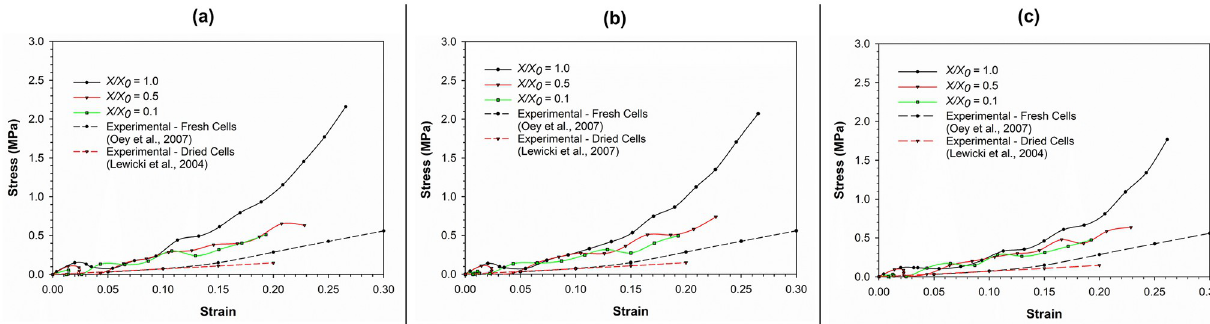
Fig 9. The stress-strain relationships demonstrated by the SPH-CG cell computational model at different dryness levels. at: (a) high turgor pressure (300 kPa); (b) normal turgor pressure (200 kPa); (c) low turgor pressure (100 kPa). ( X/X 0 is the normalised moisture content).